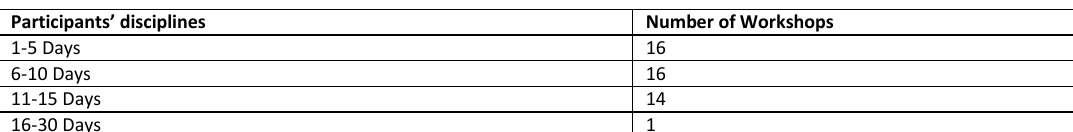
Table 10 The number of workshops across workshop duration